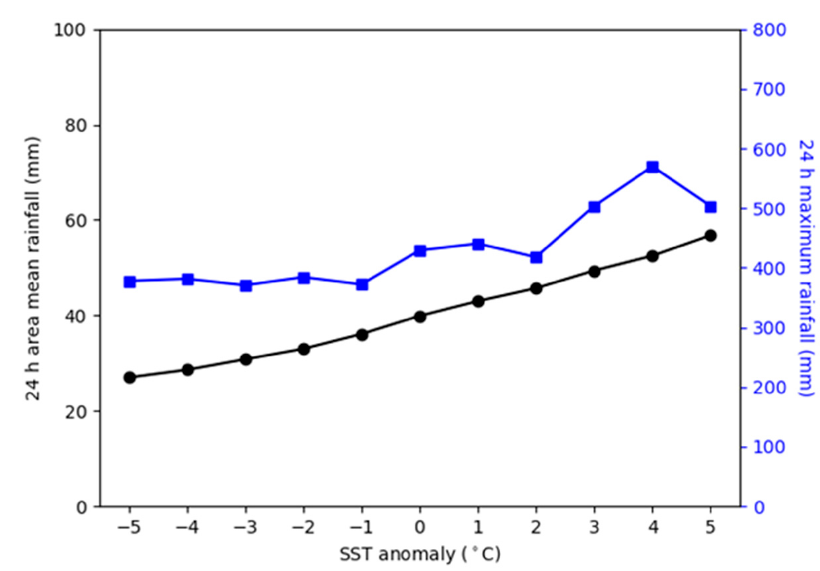
Figure 20. 24 h area mean accumulated (black) and maximum accumulated rainfall (blues) in mm for all sensitivity experiments.